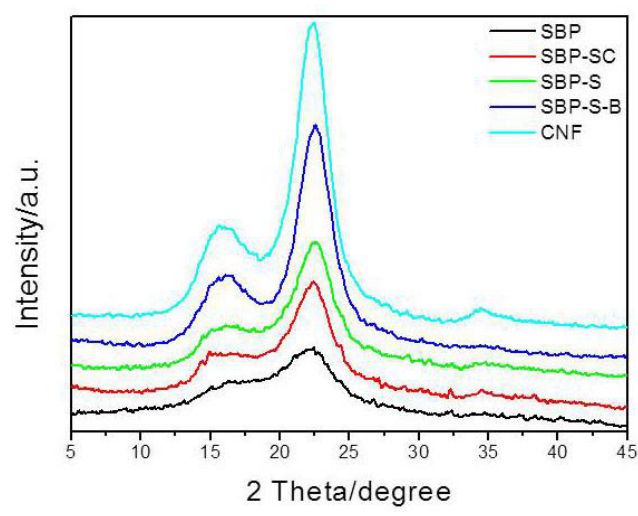
Figure 3. X-ray diffraction (XRD) patterns for SBP, SBP-SC, SBP-S, SBP-S-B, and the CNFs. Table 2. Maximum degradation temperatures and crystallinity indices of samples at different stages.